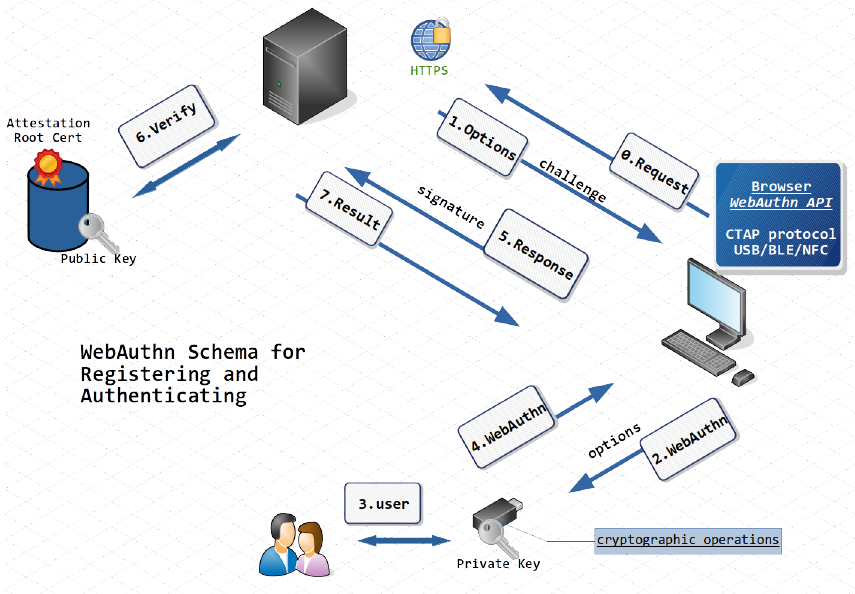
Figure 1. WebAuthn schema used by the developed tool for registration and authentication